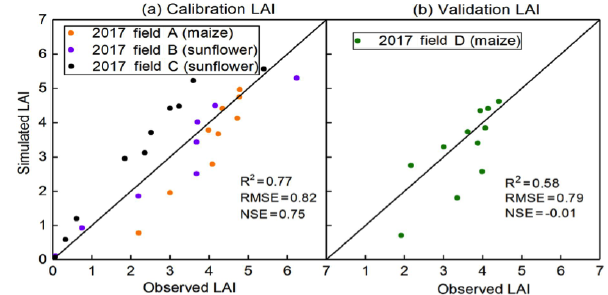
Figure 13. Comparison of predicted and observed LAI: (a) calibra- tion and (b) validation.